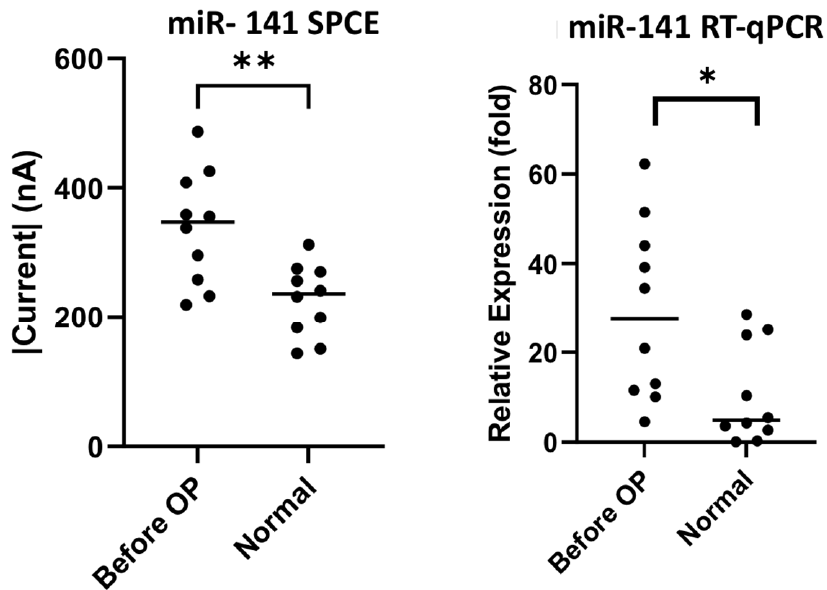
Figure 6. miR-141 sensor detection and RT-qPCR analysis of urine samples of colorectal cancer pa- tients and healthy subjects. * p -value < 0.05, ** p -value < 0.005.